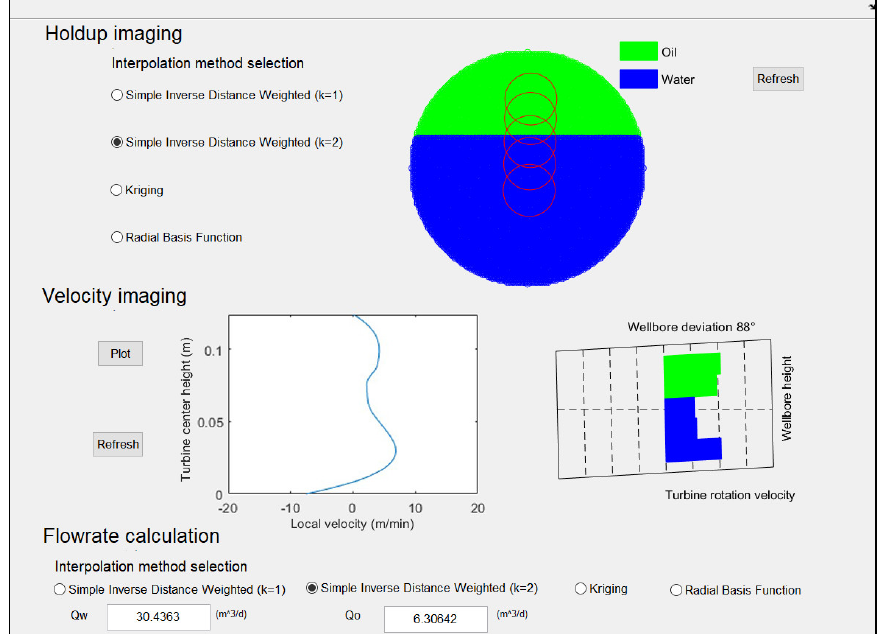
Figure 10. The second GUI program and calculation results.